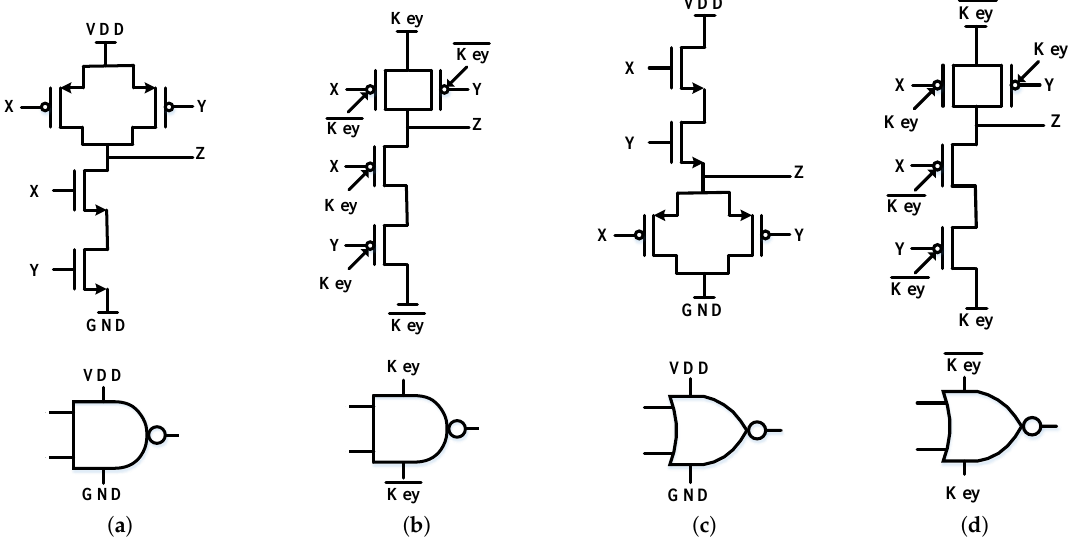
Figure 3. Different logic gates using complementary metal oxide semiconductor (CMOS) and silicon nanowire (SiNW) devices: ( a ) traditional CMOS NAND gate ( b ) silicon nanowire field effect transistors (SiNW FETs) NAND gate ( c ) conventional CMOS NOR gate ( d ) SiNW FETs NOR